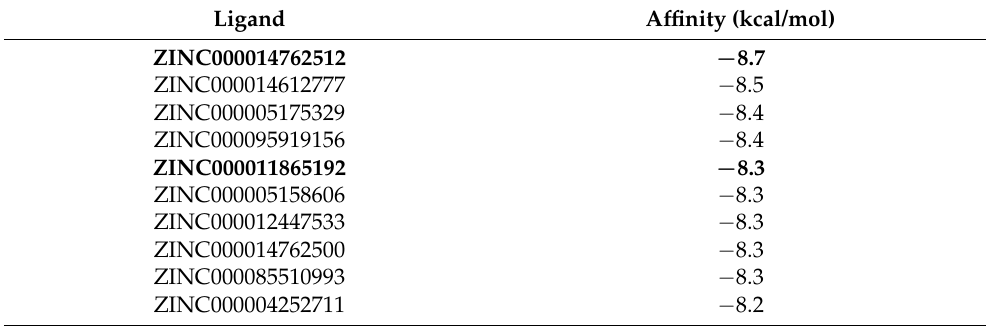
Table 1. Top 10 scoring molecules against PhcA receptor.